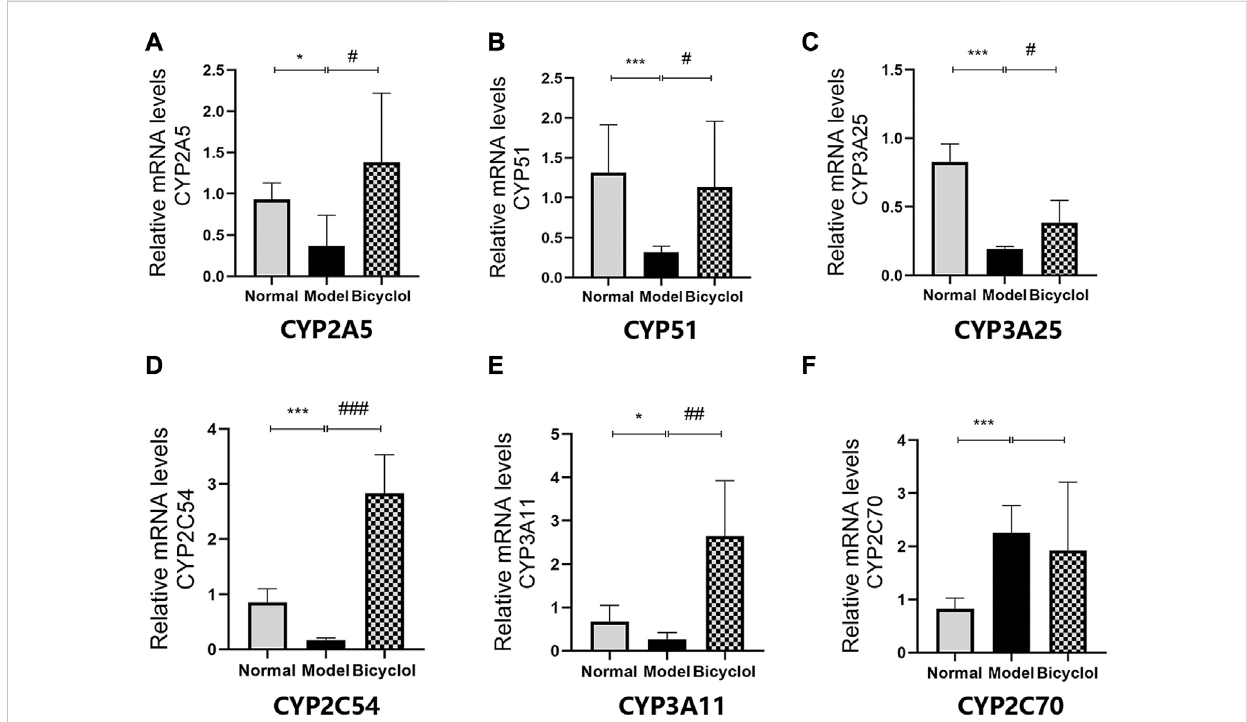
Expression of the genes involved in P450 pathway. Relative mRNA levels of (A) CYP2A5 (n = 5), (B) CYP51 (n = 8), (C) CYP3A25 (n = 6), (D) CYP2C54 (n = 8), (E) CYP3A11 (n = 6), (F) CYP2C70 (n = 5)." p < 0.05 vs Normal, *** p < 0.001 vs Normal, # p < 0.05 vs Model, ## p < 0.01 vs Model, ### p < 0.001 vs Model.